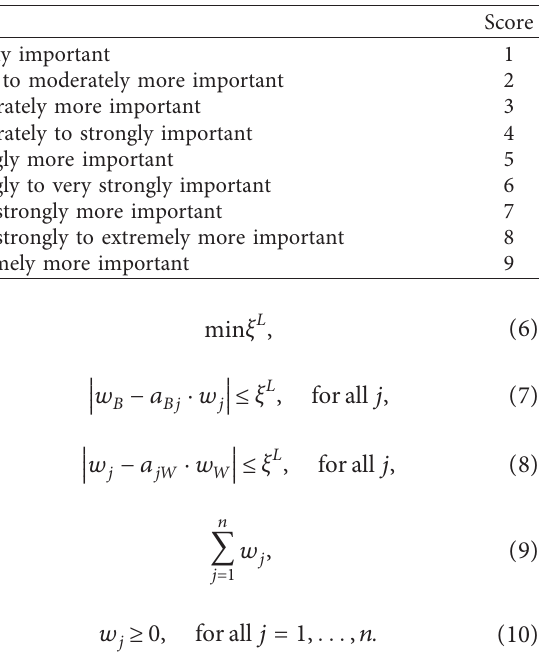
Table 2: Linguistic scale for pairwise comparison for